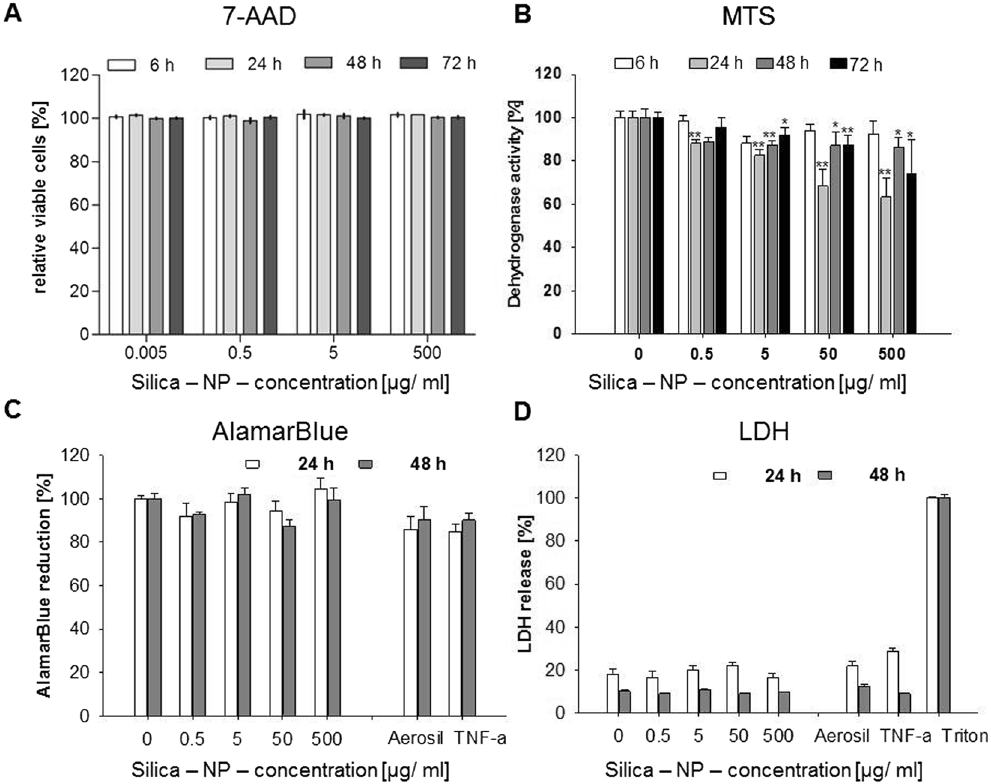
Figure 2. Vitality of HepG2 cells after incubation with SiO 2 -NP measured as determined by different laboratories and read-outs (each partner performed one assay). HepG2 cells were incubated with increasing concentrations of the SiO 2 -NP for different incubation times (up to 72 h). ( A ) Cytotoxicity measurements by flow cytometry (7-AAD staining). ( B ) Effect of SiO 2 -NP on metabolic dehydrogenase activity as detected via MTS-assay. ( C ) Determination of cellular dehydrogenase activity as detected via AlamarBlue assay. ( D ) LDH release after nanoparticle exposure. In ( C , D ) 250 µ g/mL Aerosil 200-NPs und 20 ng/mL TNF- α were additionally used as controls. All data were normalized to control values (no particle exposure or Triton X-100), which were set as 100%. ( A ) N = 3; B: N = 1, 6 parallels; ( C , D ) N = 3, technical duplicates, means and standard deviation ( * p < 0.05; ** p < 0.01, *** < 0,001 in comparison to untreated controls).